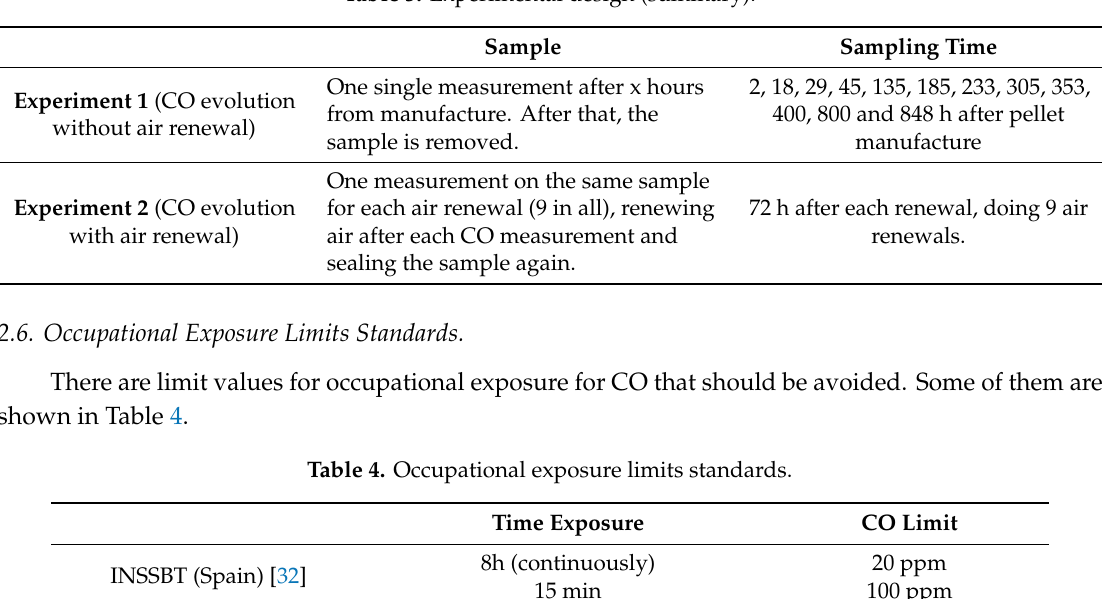
Table 3. Experimental design (summary).